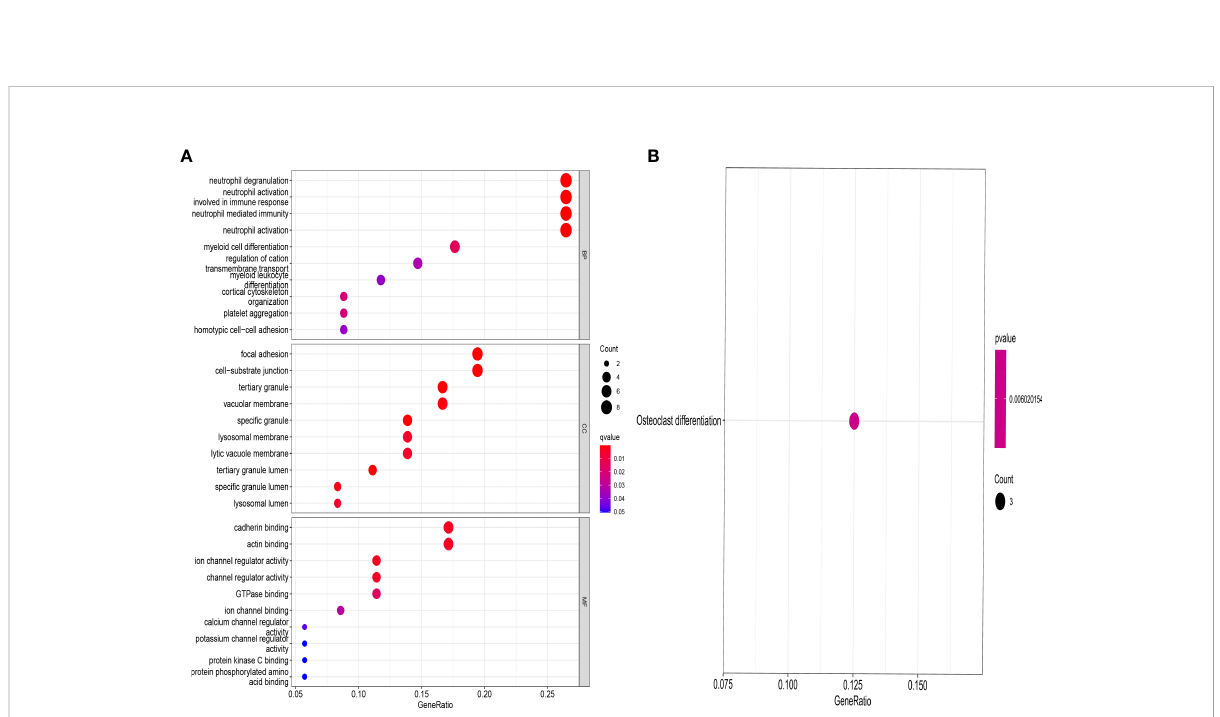
FIGURE 5 GO and KEGG enrichment analysis of DEGs. GO (A) and KEGG (B) showing functional enrichment of DEGs between the genecluster A and genecluster